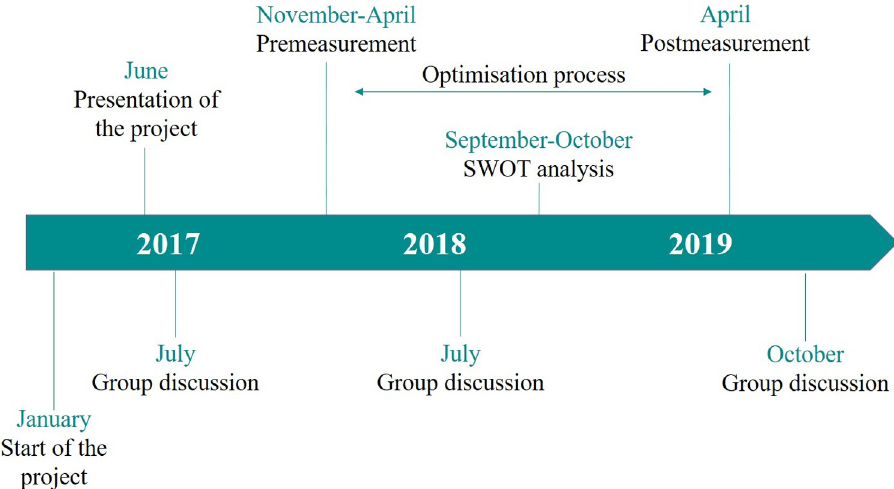
Fig 1. Study design and timeline. Description: The timeline shows the individual components of the project. Beginning in January 2017, the project was presented at the Medical Faculty of Hamburg’s annual faculty meeting in June. Above the timeline, the time points of the quantitative surveys and the SWOT analysis are shown. The optimization process took place between the pre- and postmeasurement. Group discussions took place in July 2017, July 2018 and October